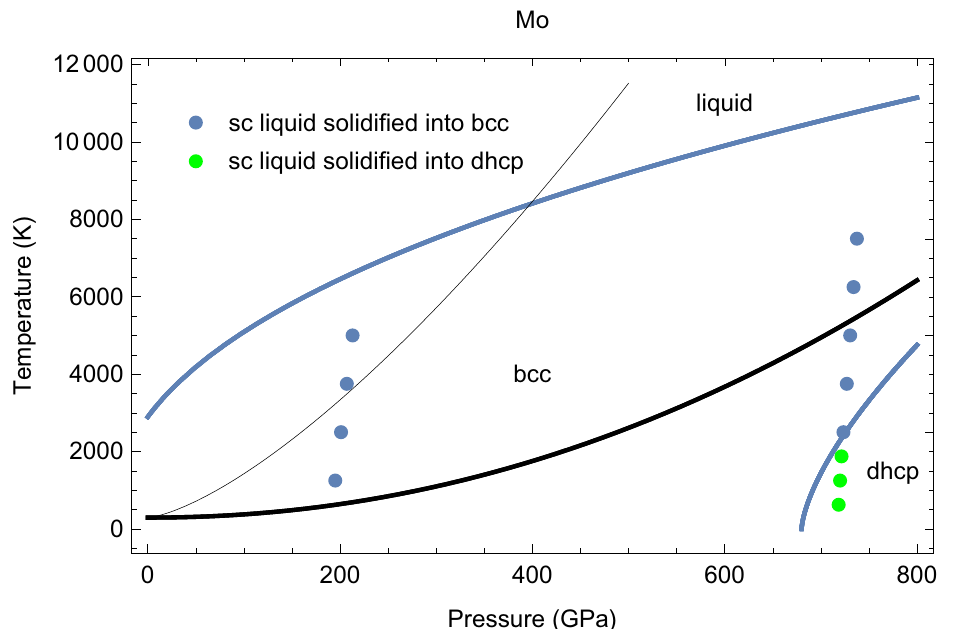
Figure 11. The phase diagram of Mo. RWT and shock Hugoniot are shown as black thick and thin lines,